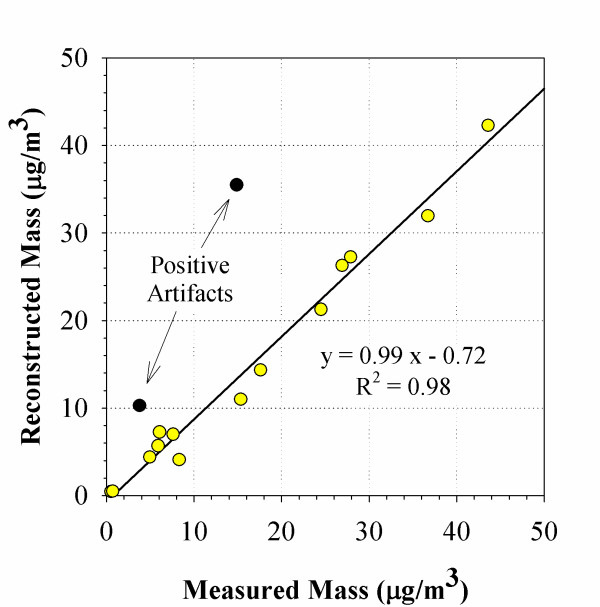
Correlation between the gravimetrically determined and chemically reconstructed PM mass. The figure shows a very good correlation between the PM mass determined gravimetrically from the Teflon filters and the PM mass reconstructed from chemical analysis (mostly on quartz filters) for samples collected in four different locations. There are two exceptions where positive adsorption artifacts are obvious for the quartz filter samples collected next to the CA-110 freeway. Excluding these two outliers, this graph indicates that the effect of these artifacts is limited at all other sampling locations.